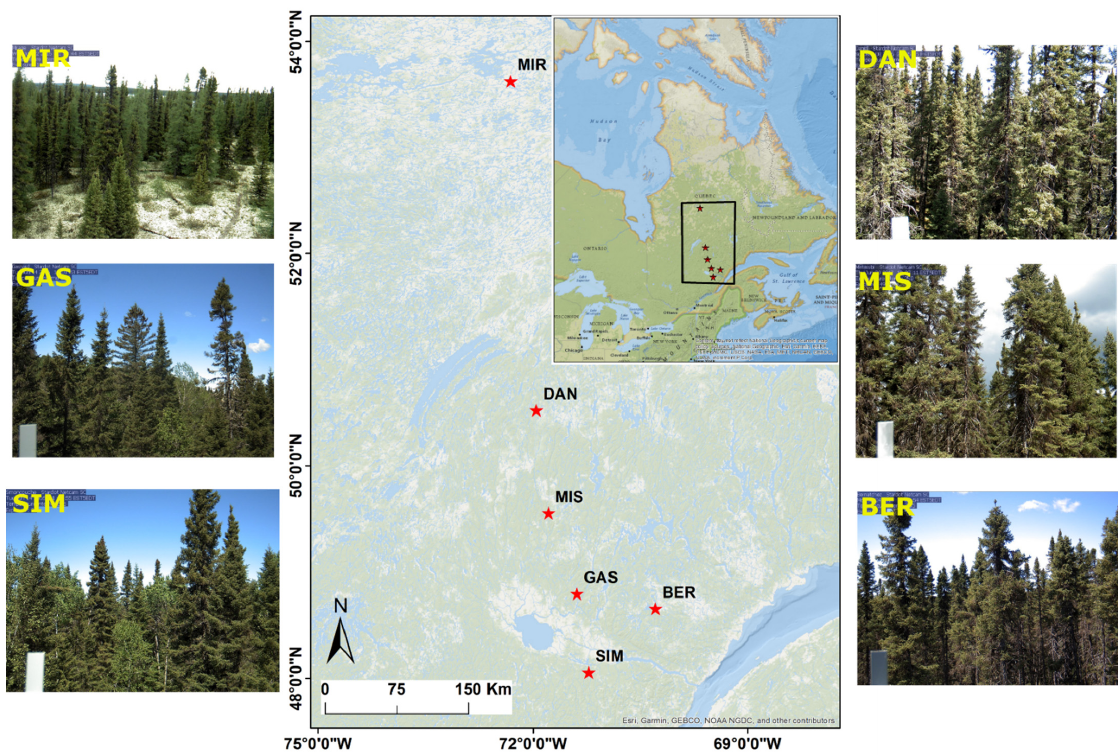
Figure 1. Coverage area of PhenoCam sites: Simoncouche (abbreviated as SIM), Gaspard (GAS), Bernatchez (BER), Mistassibi (MIS), Camp Daniel (DAN), and Mirage (MIR) along the latitude in Quebec, Canada, and corresponding PhenoCam images of June for each site. Table 1. Summary of PhenoCam site characteristics for Simoncouche (abbreviated as SIM), Gaspard (GAS), Bernatchez (BER), Mistassibi (MIS), Camp Daniel (DAN), and Mirage (MIR). Total Number of Available Pheno- Altitude Site Coordinate (m)